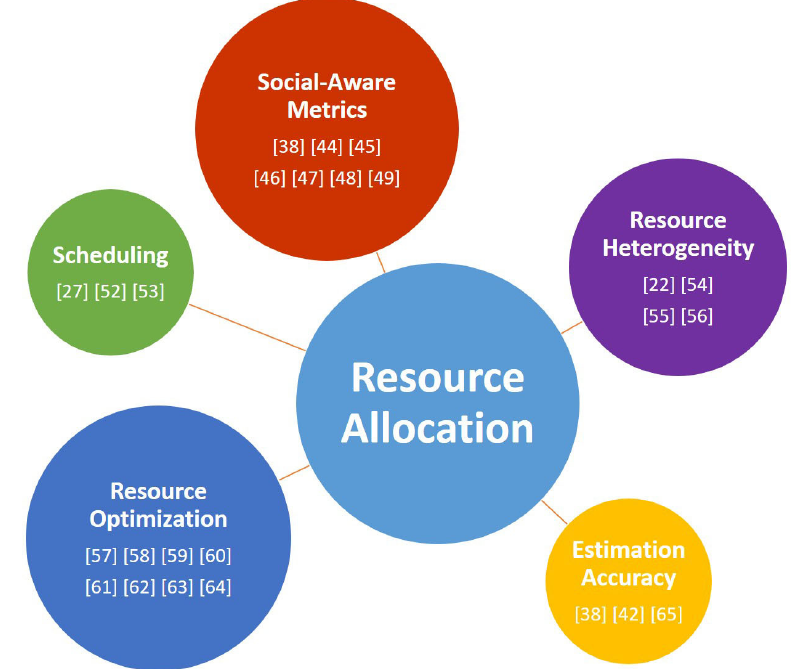
Figure 4. Resource allocation works grouped considering key requirements to design social-aware resource allocation and optimization for D2D